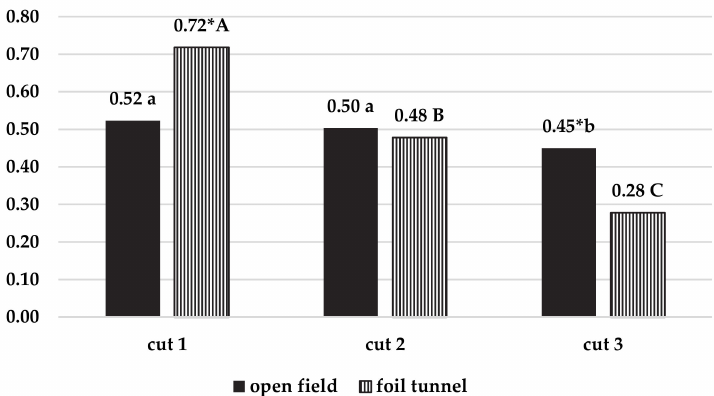
Figure 2. The content of essential oil in common thyme herb (g × 100 g − 1 FW). Tukey test; * p < 0.05; a, b are the means marked with small letters (values for following cuts in the open field) differ at p < 0.05; A, B, C are the means marked with capital letters (values for following cuts in the foil tunnel) differ at p <